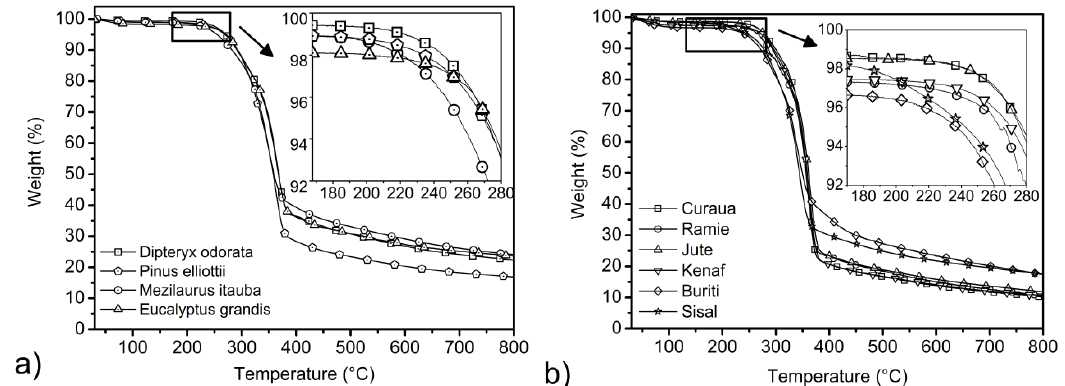
Figure 4. Thermogravimetric curves for the wood ( a ); and vegetal fibers ( b )